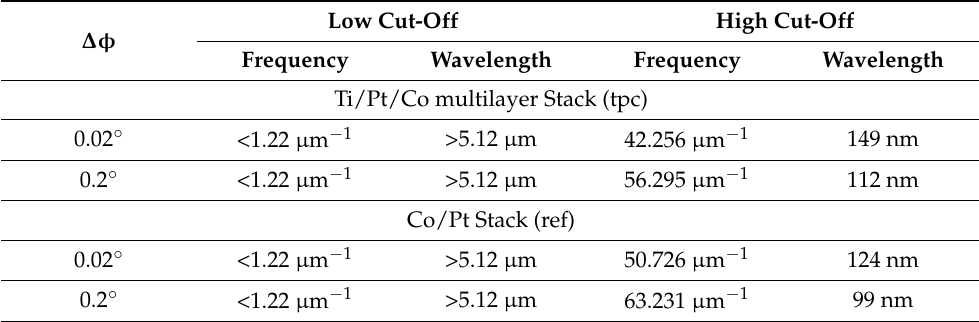
Figure A5. Estimation of accessible wave vector range after calibration; tip mediated sensitivity, dB z , and circularly averaged sample, σ , distribution in Fourier space for the Ti/Pt/Co ( a ) and the Co/Pt sample ( b ). The inset shows the generic tips, dB z , in real space; ( c , d ) show the phase shift distribution of a simulated reference sample measurement using the generic tip for the Ti/Pt/Co and the Co/Pt sample, respectively. The horizontal lines show the noise floor for white Gaussian noise with 0.2 ◦ (black) and 0.02 ◦ (green) standard deviation. Table A2. Cut-off wave vector and corresponding wavelength data for the Ti/Pt/Co and the Co/Pt sample for two different noise